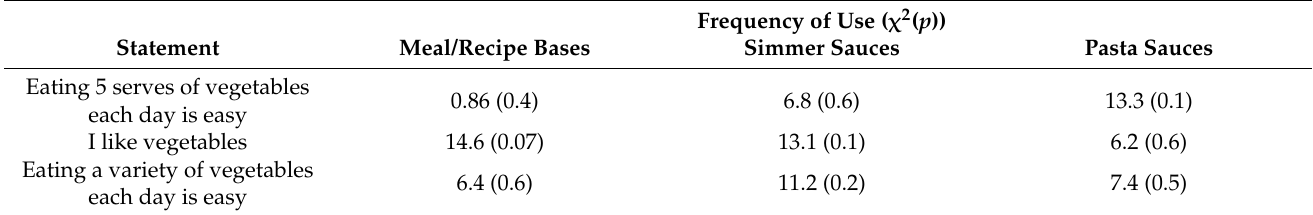
Table 3. Correlation between vegetable eating opinions and convenience cooking product frequency of use.